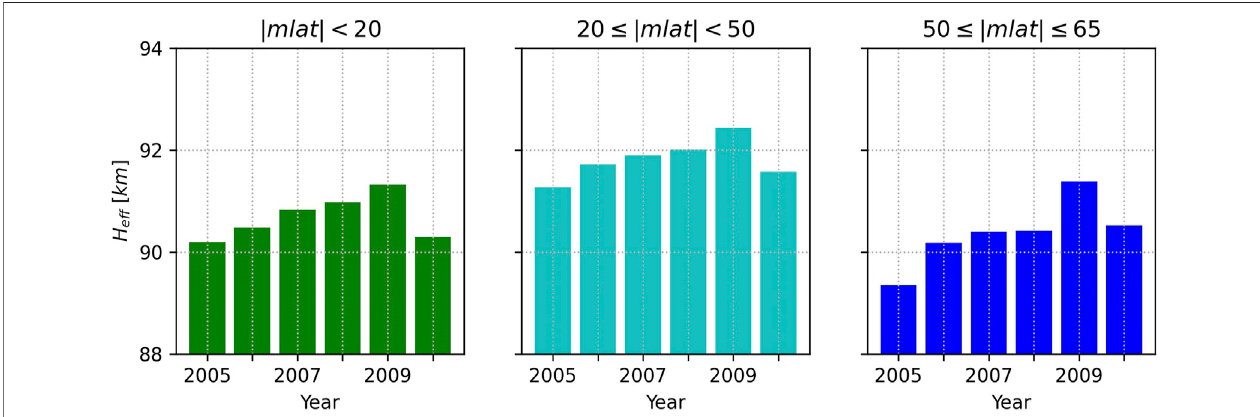
FIGURE 8 | Yearly averages of the Earth – ionosphere waveguide ’ s effective height based on DEMETER observations. A similar solar cycle modulation is evident in each of three latitude ranges.